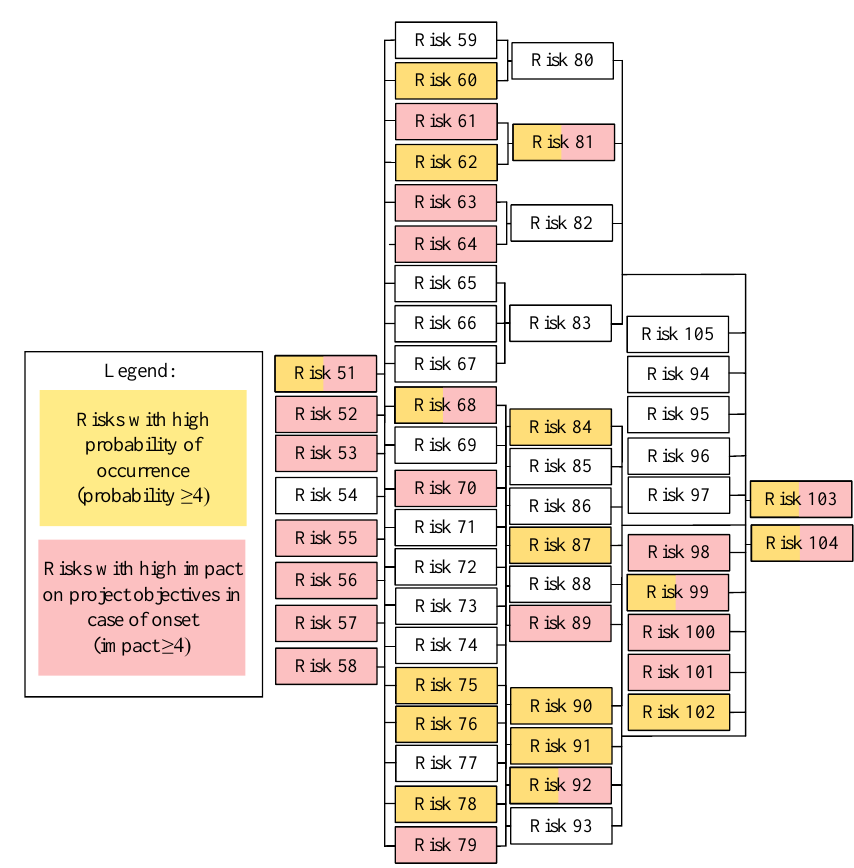
Figure 3. Model of cause-and-effect relationships of project risks of IT projects.